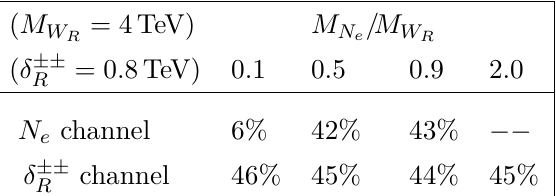
/M W ( M W = 4 TeV , M = 0 . 8 TeV δ ±± e R R R